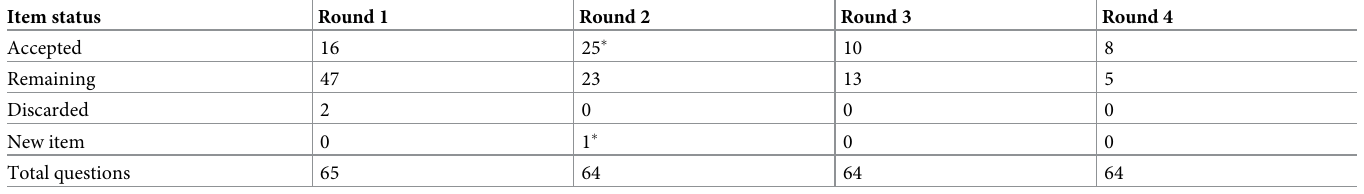
Table 2. Participant agreement (based on the pre-established agreement thresholds described in the methodology) for individual question items during the SRS-2 rounds of the Delphi